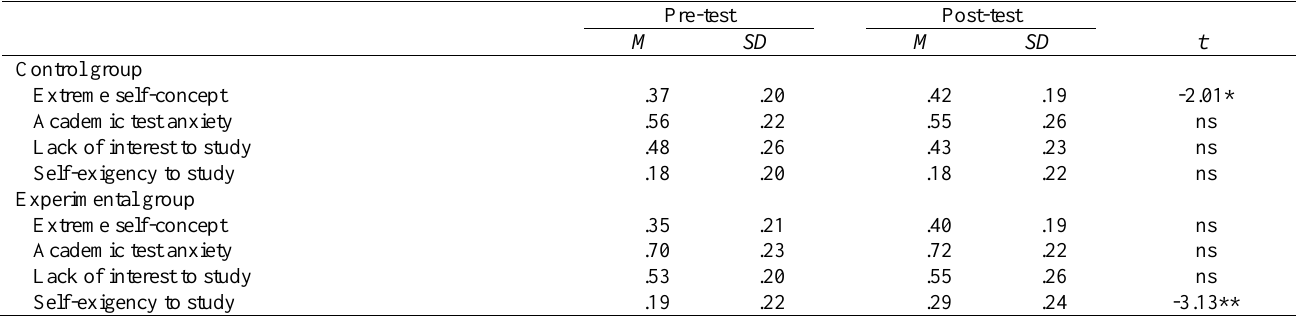
Table 6: MA factors: Paired-comparison t-test for control and experimental groups